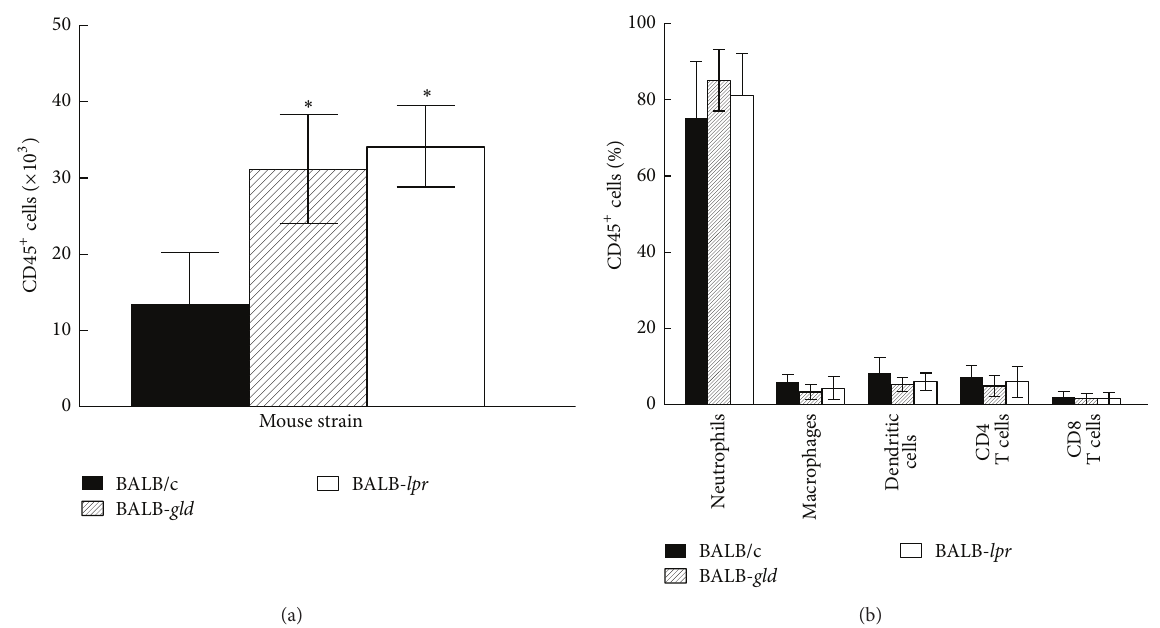
Figure 5: Inflammatory infiltrate in the corneas of BALB- gld and BALB- lpr mice displays significant increased CD45 + cells, though there are no qualitative differences in subpopulations of CD45 + cells. Mice were infected in one eye with HSV-1 and reactivated 8 weeks later by UV-B irradiation. The HSV-infected corneas were removed at days 17 and 23 after irradiation from mice with severe HSK disease and disaggregated into single-cell suspensions and stained with anti-CD45 (a). The CD45 + cells were gated and further analyzed for staining with anti-CD4, CD8 𝛼 , Gr-1, CD11b, CD11c, and F4/80 mAb (b). Cells were analyzed by flow cytometry. Data represents 4 to 6 corneas per group. Significant differences were seen in CD45 + cells (a) ( 𝑃 < 0.05 –0.02), but not for the percentages of CD45 + subsets (b) ( 𝑃 > 0.05 ).